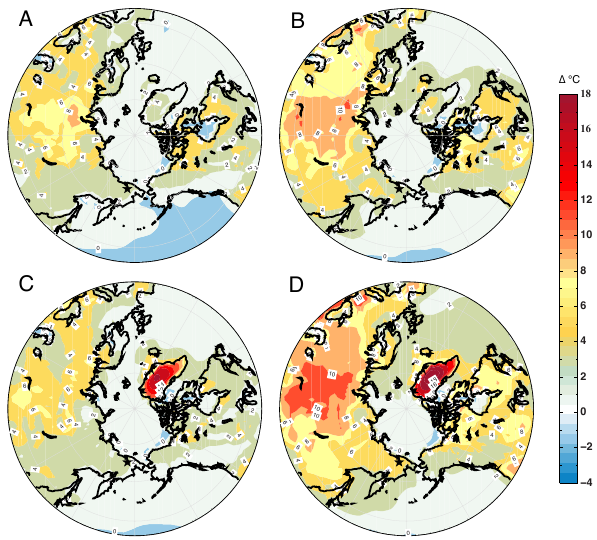
Figure 3. Simulated interglacial anomalies (2m annual air temper- ature in ◦ C) compared to preindustrial temperatures: (a) MIS 1 (9ka orbit and GHGs), (b) MIS 5e (127ka orbit and GHGs), (c) MIS 11c (409ka orbit and GHGs but no Greenland Ice Sheet) and (d) MIS 31 (1072ka orbit and GHGs but no Greenland Ice Sheet). The loca- tion of Lake E (black star) is shown near the bottom of each panel. Areas of no shading (white) roughly correspond to no change that is statistically significant at the 95% confidence